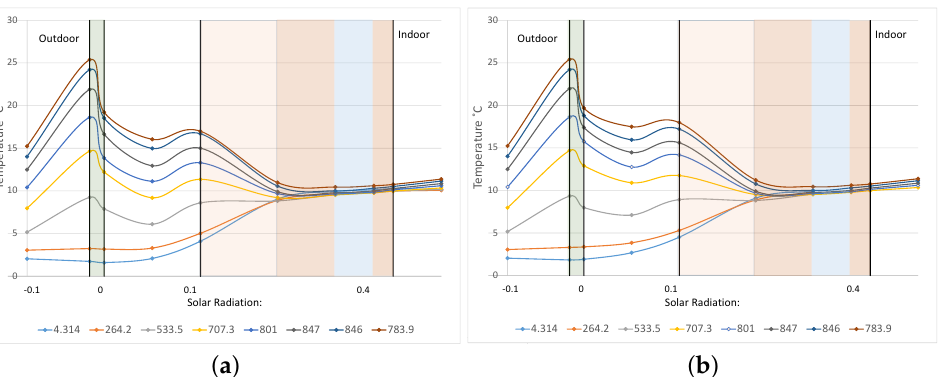
Figure 24. Trend of measured and calculated temperatures in the different layers of the southern ventilated façade for daily hours with different solar radiation and temperature values under winter conditions (14 January 2021), for: ( a ) Zone 2; ( b ) Zone